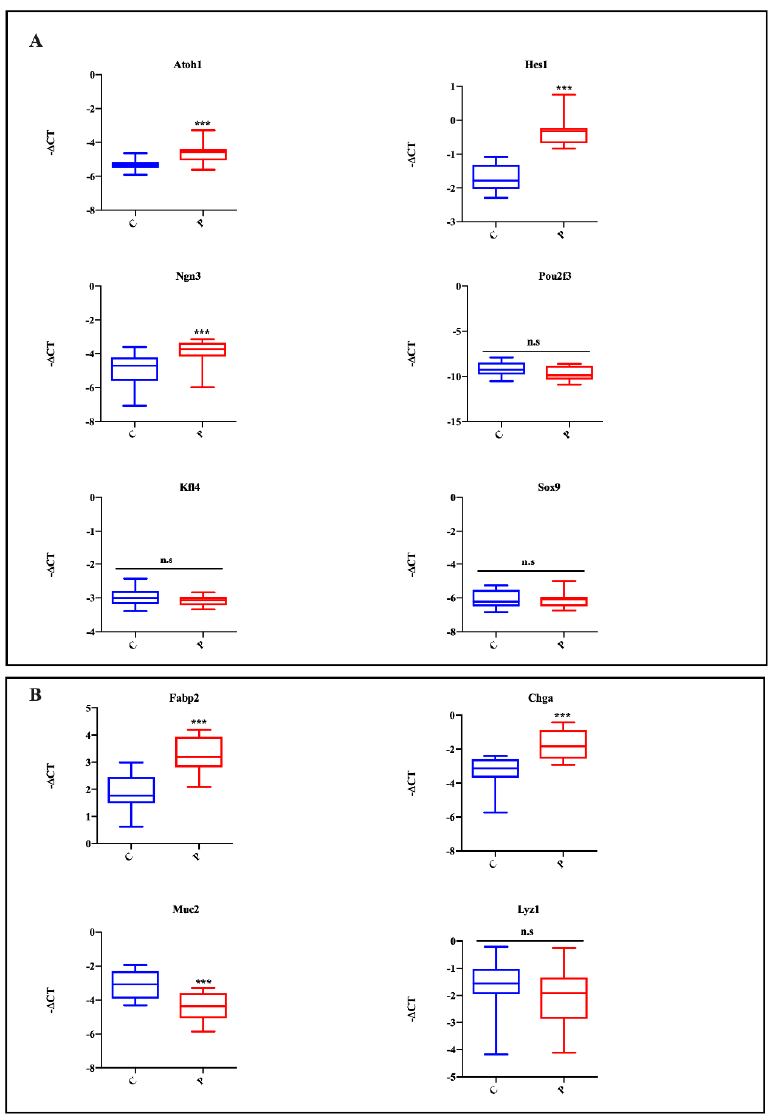
Figure 4. Effect of palmitate treatment TFs and specific intestinal epithelial lineage marker expression. Atoh1, Hes1, Neurog3, Pou2f3, Klf4 and Sox9 ( A ); Fabp2, ChgA, Muc2 and Lyz1 ( B ). Data generated from three biological replicates from five mice. Unpaired Student’s t test: *** p < 0.001; n.s., not significant. C, control; P, palmitate.